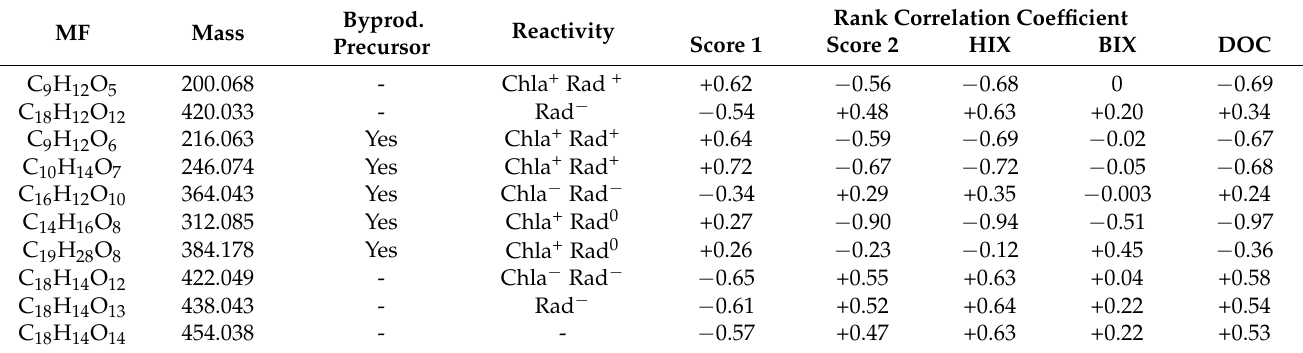
Table 2. Selected molecular formulas (MFs), their molecular masses, reactivities (Chla: correlation to chlorophyll a; Rad: correlation to radiation; and +/ − /0: positive/negative/no correlation), and rank correlation coefficients between photo products or photo-degraded compounds and the scores of the PARAFAC components as well as the fluorescence indices HIX, BIX, and the DOC. Chla + Rad + are photo products, Chla − Rad − are photo-degraded compounds, Chla + Rad 0 are microbial products, and Rad- are also photo degraded compounds [30], the byproducts of which are potential precursors for disinfection byproducts